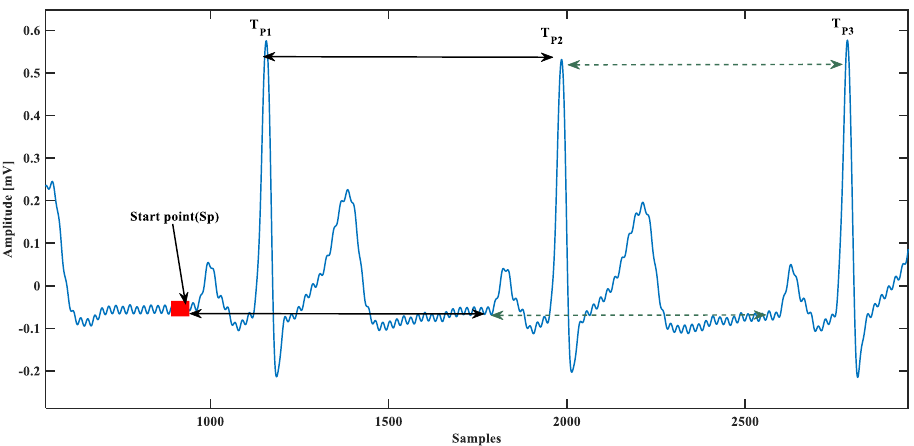
Figure 3. Automated electrocardiogram (ECG) beat separation from the database.